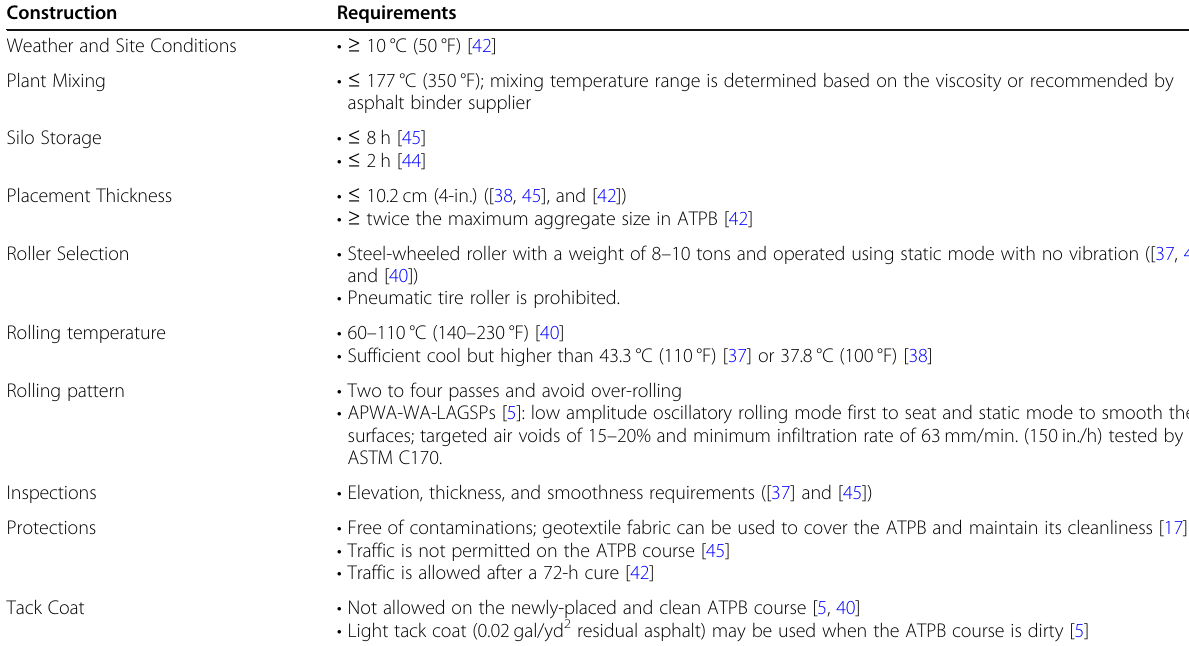
Table 6 Construction requirements of the asphalt-treated permeable base in cold regions